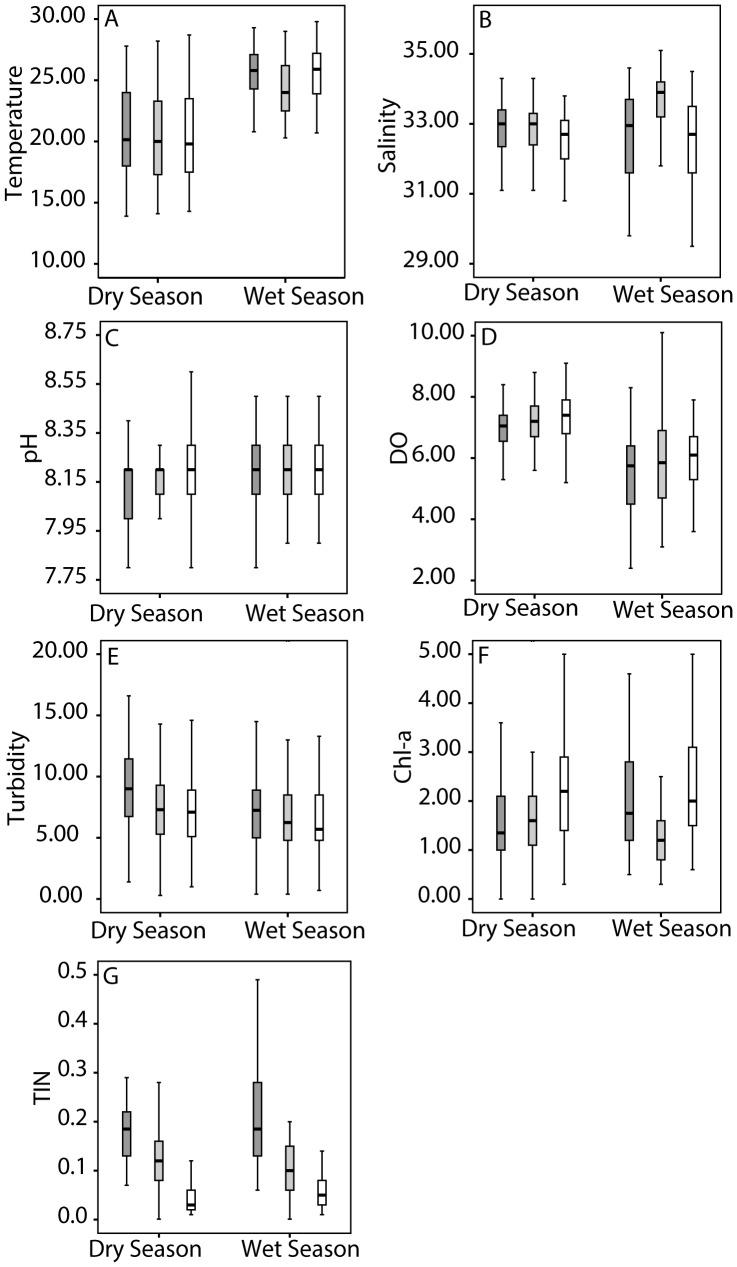
Monthly hydrographic data divided into the wet season (April-September) and the dry season (October-March) plotted to show the median (bold mid-line), the first and third quartiles (box), and 1.5 times each quartile (black lines) for Lamma Island (dark shading), Pak Lap Tsai (light shading) and Crescent Island (no shading).Data is shown for a) temperature (deg C), b) salinity (psu), c) in situ pH, d) dissolved oxygen (mg L−1), e) turbidity (NTU), f) chlorophyll-a (µg L−1), and g) total inorganic nitrogen (mg L−1).